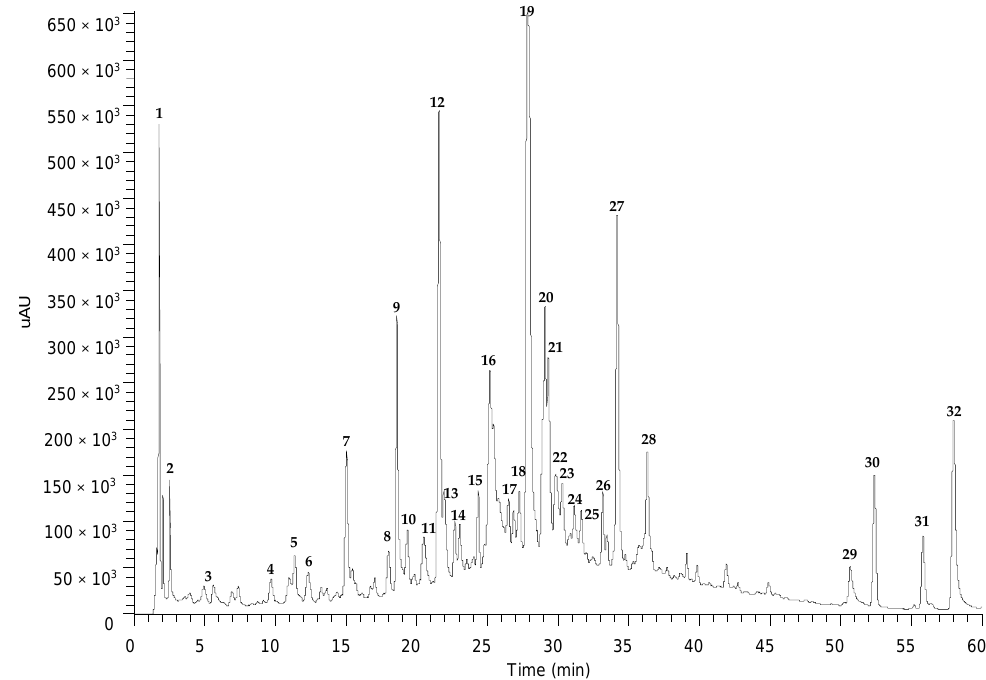
Figure 1. GC - FID chromatogram of EO of Thymbra capitata on the SPB - 1 column.